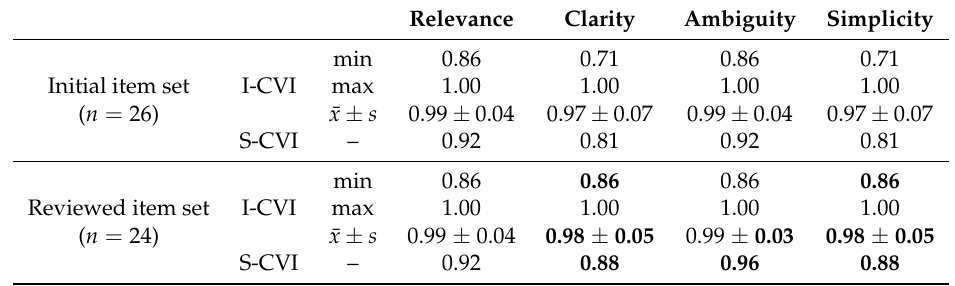
Table 2. I-CVI statistics and S-CVI values for the initial and reviewed set of questionnaire items. Changing values are in